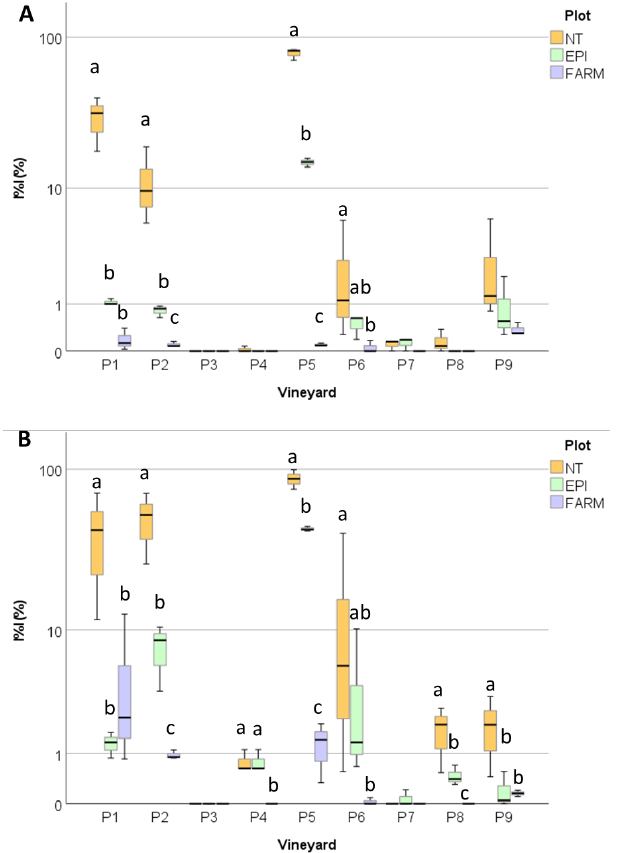
Figure 11. Box plot distribution of the final disease severity on leaves ( A ) and bunches ( B ) registered in 2021 in the untreated (NT), EPI (EPI), and farmers’ strategy (FARM) plots of the nine vineyards (P1–P9). Different letters indicate significant differences among samples ( p < 0.05).